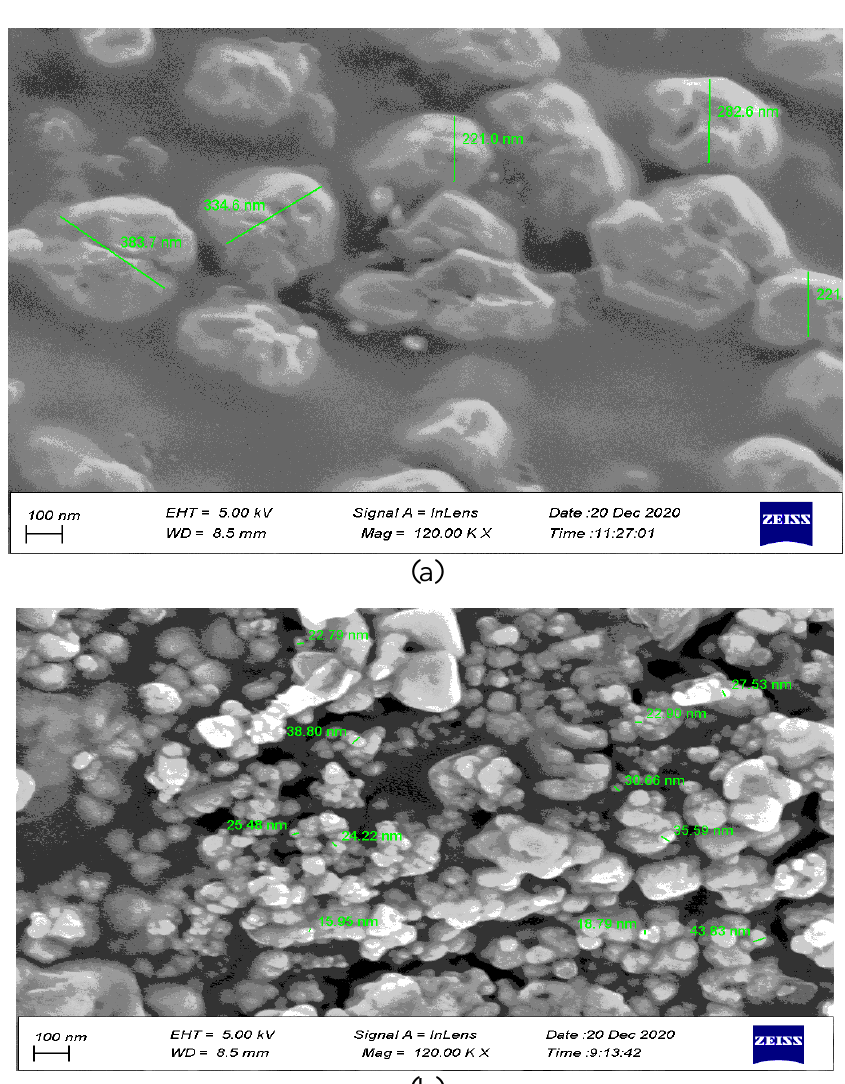
Figure 8: SEM micrograph of: a.blend (epoxy& Repcoat ZR) and b. blend with graphene